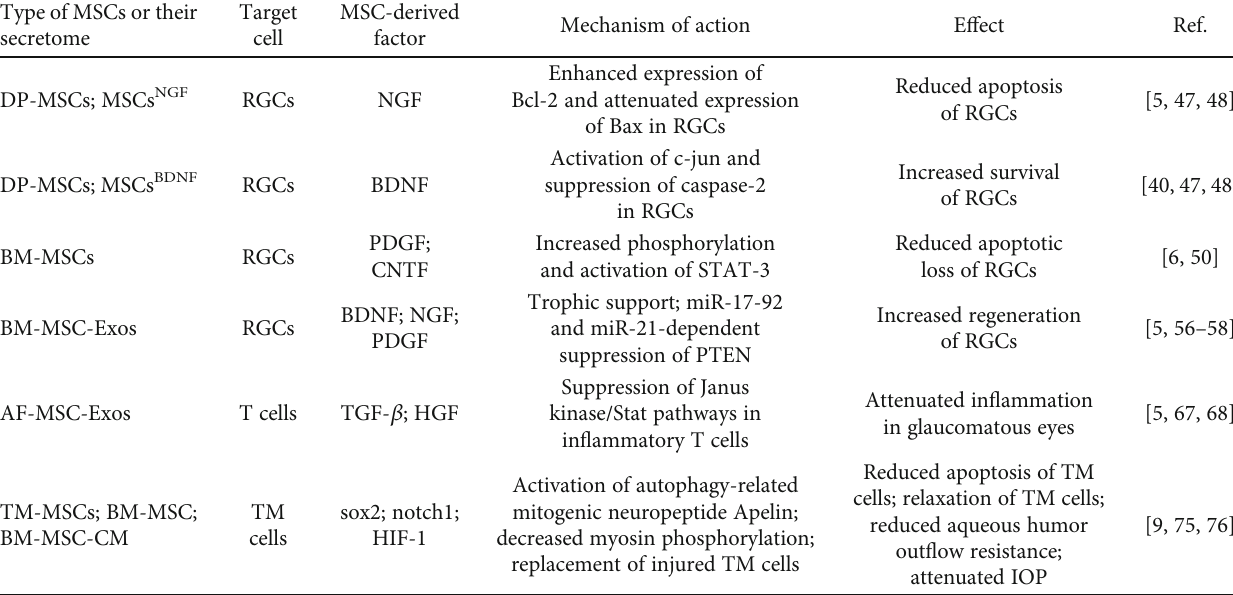
Table 1: Molecular mechanism responsible for bene fi cial e ff ects of MSCs and their secretome in glaucoma treatment. Type of MSCs or